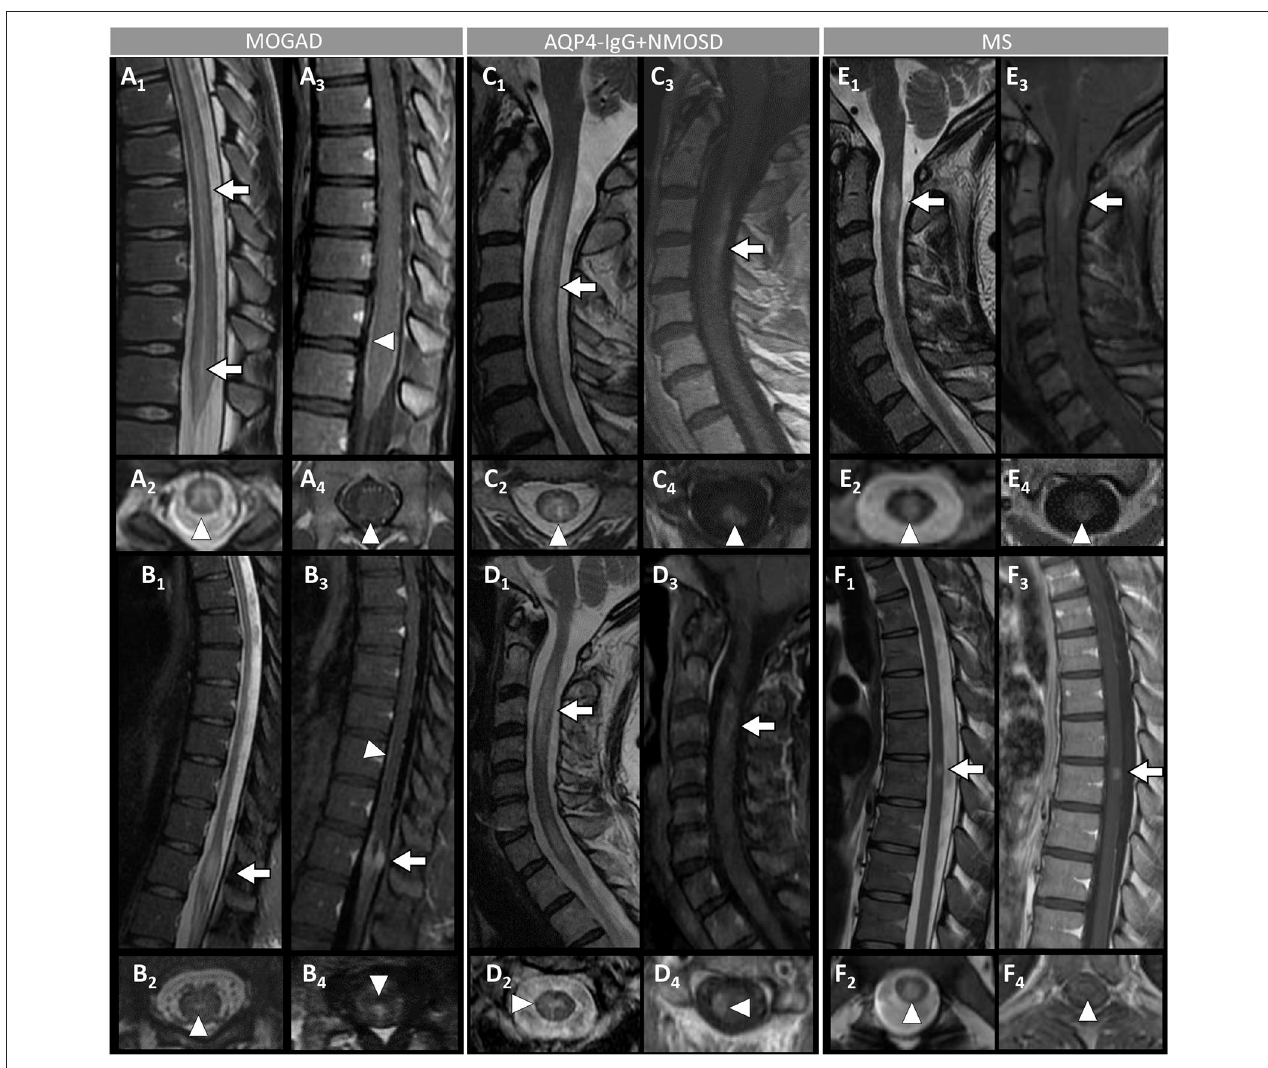
FIGURE 4 | Spinal cord MRI features in patients with MOGAD, AQP4-IgG + NMOSD, and MS. [ (A,B) : MOGAD] A longitudinally-extensive T2-hyperintense lesion involving the conus medullaris on sagittal images (A 1 , arrows), with T2-hyperintensity restricted to the gray matter forming a H-sign on the axial view (A 2 ), accompanied by leptomeningeal enhancement but no spinal cord parenchymal enhancement on T1-post-gadolinium images (A 3 , sagittal view, arrowhead, and A 4 , axial view, arrowhead); a sagittal short T2-hyperintense lesion involving the conus (B 1, arrow), centrally located on axial images (B 2 , arrowhead), with corresponding gadolinium-enhancement (B 3 , arrow) and leptomeningeal enhancement on T1-post-gadolinium images (B 3 , sagittal view, arrowhead, and B 4 , axial view, arrowhead). [ (C,D) : AQP4-IgG + NMOSD] A sagittal longitudinally-extensive T2-hyperintense cervical cord lesion with spinal cord swelling (C 1 , arrow), gray matter involvement and T2-“bright spotty sign” on axial view (C 2 , arrowhead), and gadolinium-enhancement on T1-post-gadolinium images (C 3 , sagittal view, arrow, and C 4 , axial view, arrowhead); a sagittal longitudinally extensive T2-hyperintense cervical cord lesion (D 1 , arrow), predominantly involving the right hemi-cord on axial view (D 2 , arrowhead), accompanied by ring enhancement (D 3 , arrow; D 4 , arrowhead) on T1-post-gadolinium images. [ (E,F) : MS] A sagittal short T2-hyperintense cervical cord lesion (E 1 , arrow) involving central spinal cord (E 2 , arrowhead), showing homogeneous gadolinium-enhancement on T1-post-gadolinium images (E 3 , sagittal view, arrow, and E 4 , axial view, arrowhead); a sagittal short T2-hyperintens thoracic spinal cord lesion (F 1 , arrow), involving the gray matter and the dorsal white matter tracts (F 2 , arrowhead), with homogeneous enhancement on T1-post-gadolinium images (F 3 , sagittal view, arrow, and F 4 , axial view, arrowhead). MOGAD, myelin oligodendrocyte glycoprotein antibody-associated disease; AQP4-IgG + NMOSD, aquaporin-4-IgG seropositive neuromyelitis optica spectrum disorder; MS, multiple sclerosis. Definitions: Longitudinally extensive spinal cord lesion = lesion involving ≥ 3 vertebral segments. Short spinal cord lesion = lesion involving < 3 vertebral